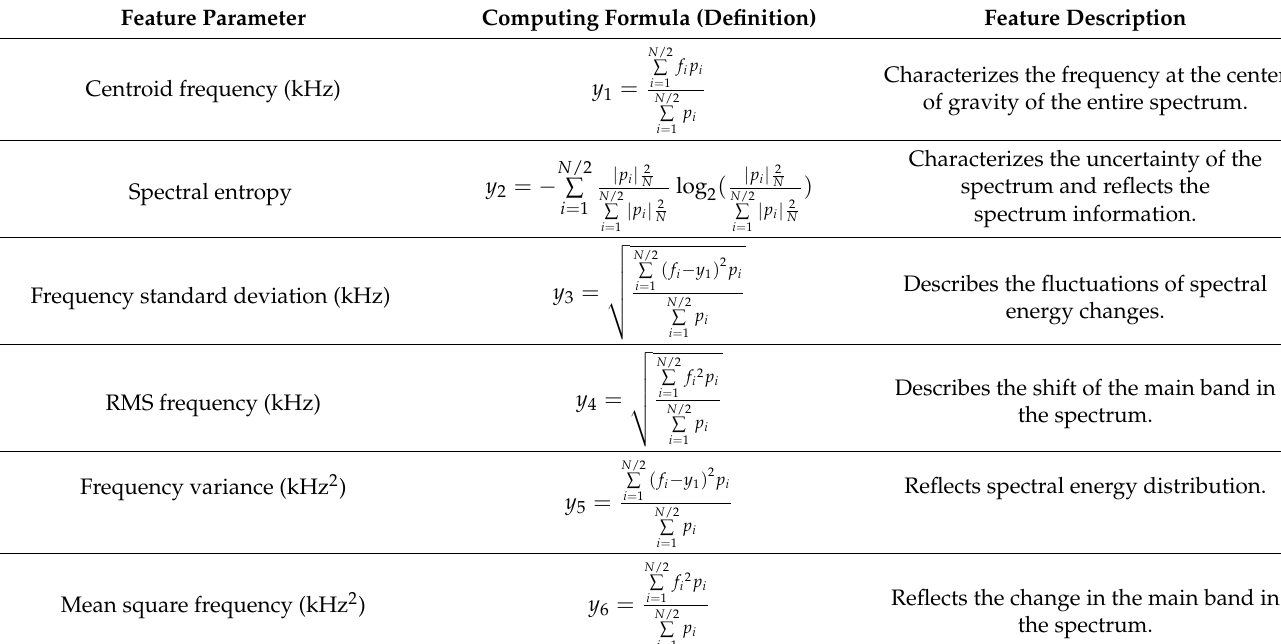
Table 3. Frequency domain characteristic